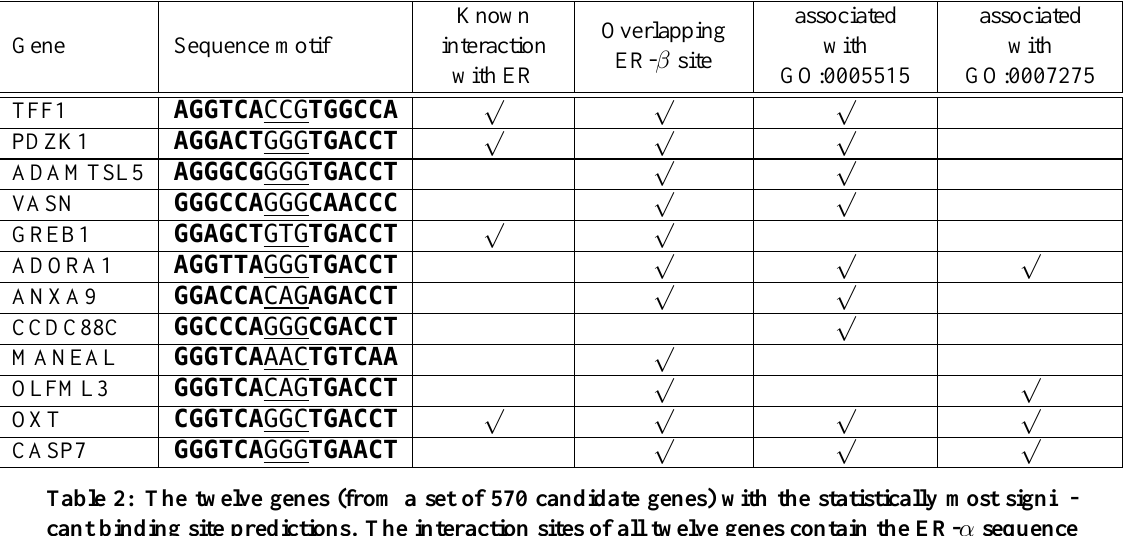
Table 2: The twelve genes (from a set of 570 candidate genes) with the statistically most signifi- cant binding site predictions. The interaction sites of all twelve genes contain the ER- α sequence motif. This is shown in column 2 with the less conserved part of the motif underlined. Four of the listed genes are known to be regulated by the estrogen receptor (column 3). The locations of the interaction sites corresponding to the twelve genes were compared with those derived from the ER- β dataset GSE21770 [32] (workflow as described in the main text). The interaction site ups tream of CCDC88C is the only site not overlapping in both datasets (column 4). GO-term analysis reveals that the terms protein binding and multicellular organismal development are both significantly over-represented in the set of 570 candidate genes. Nine of the twelve listed genes are associated with the GO-term protein binding (GO:0005515, column 5) and four with the GO-term multicellular organismal development (GO:0007275, column